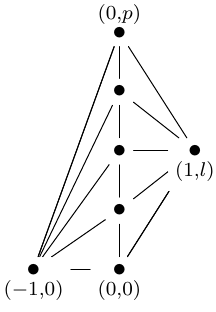
Figure 4 . Triangulation of Y p,q considered in the